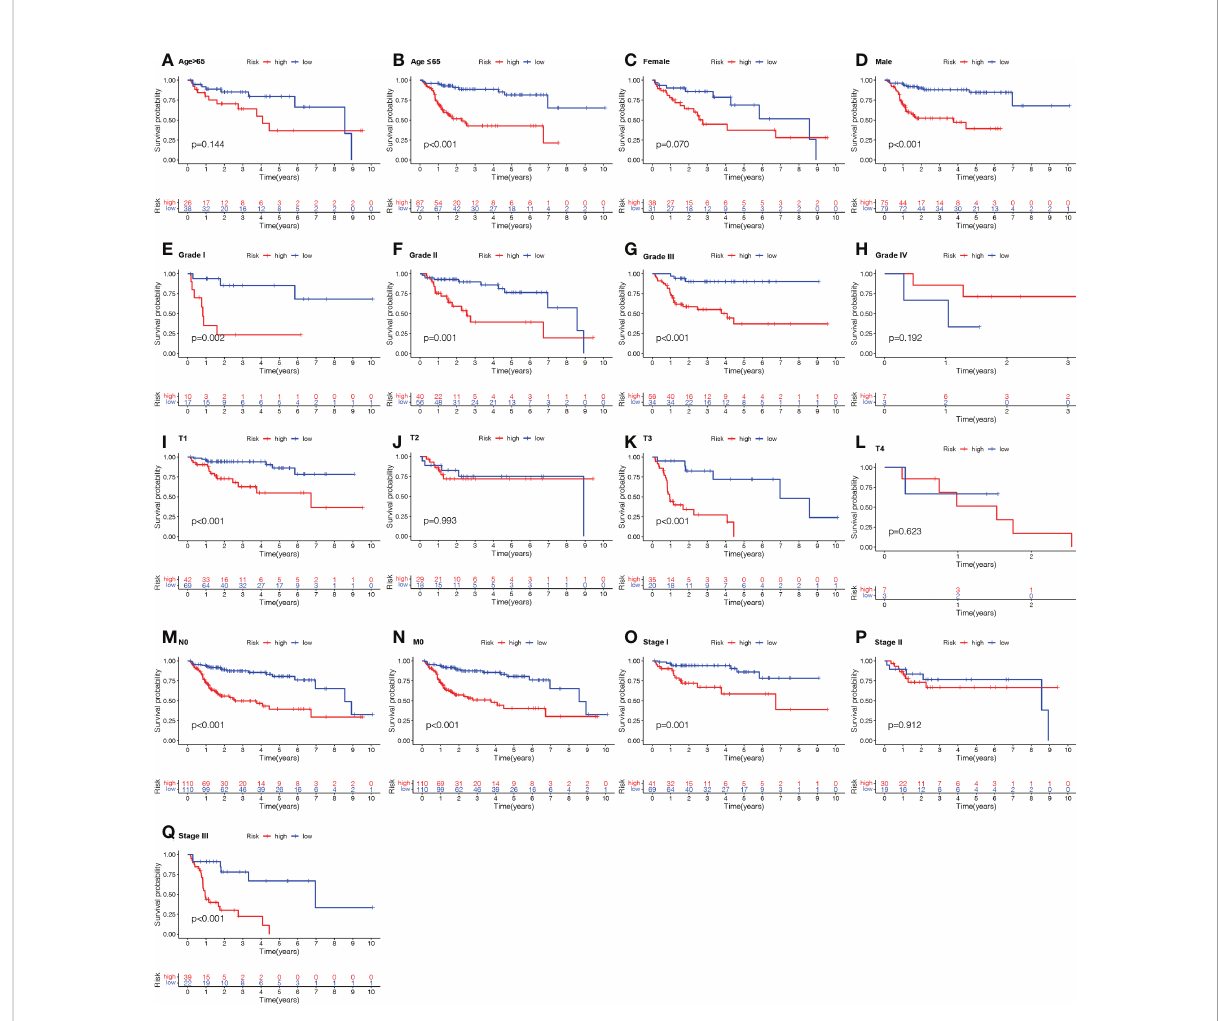
FIGURE 9 Kaplan-Meier survival graphs for high (H)- and low (L)-risk individual subgroups based on various clinic-pathological factors. (A, B) Age. (C, D) Gender. (E – H) Grade. (I – L) T stage. (M) N stage. (N) M stage. (O – Q) Stage. T, tumor; N, Node; M,